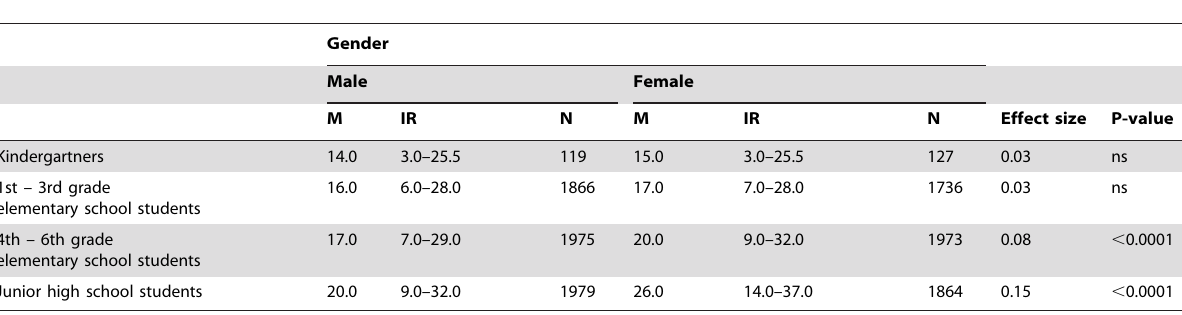
Table 2. Average PTSSC-15 score (grade & gender).